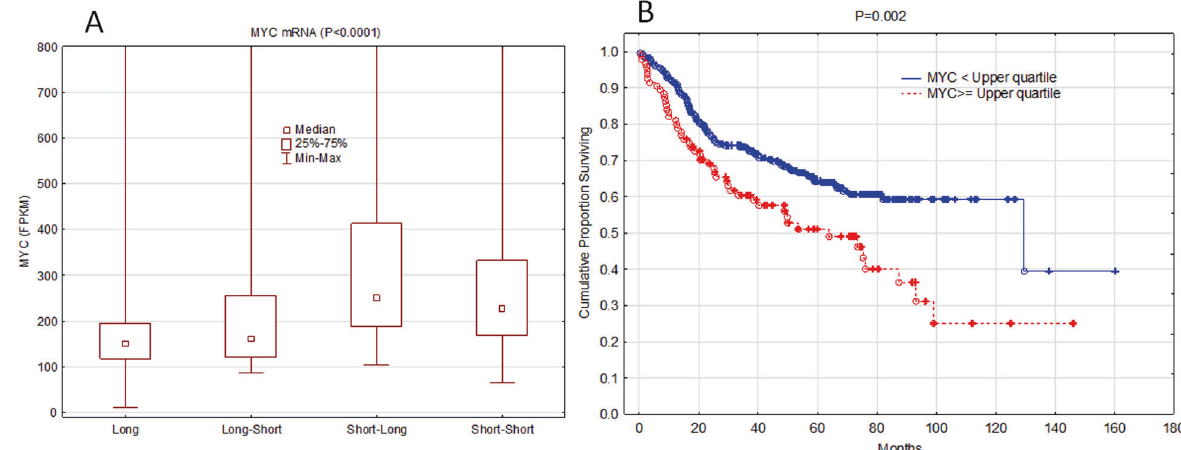
Fig. 5 MYC overexpression as predictor of survival. a The levels of MYC mRNA in various survival groups. b Kaplan – Meier survival curves of patients based on MYC